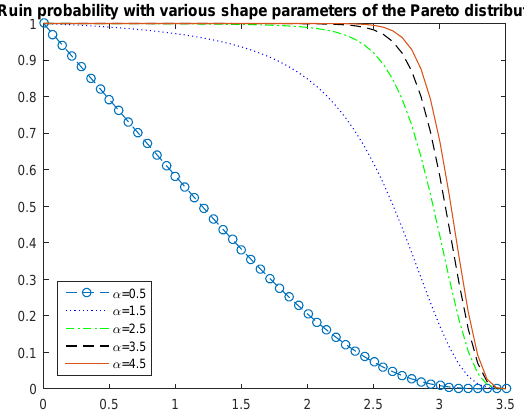
Figure 3. Ruin probabilities for Pareto ( 0.1, α ) gains for α =